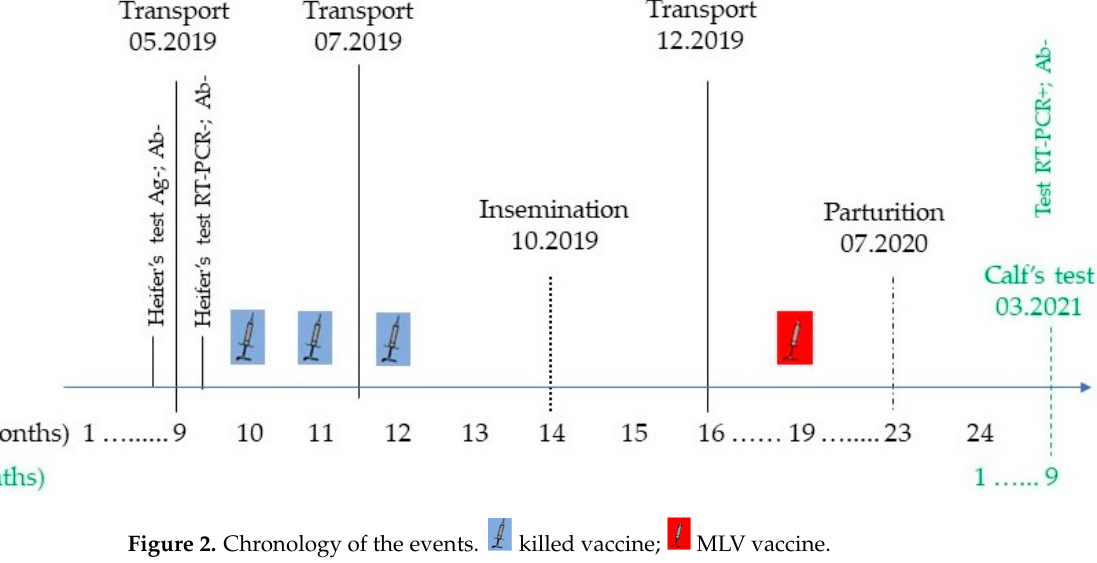
Figure 2. Chronology of the events. killed vaccine; MLV vaccine .